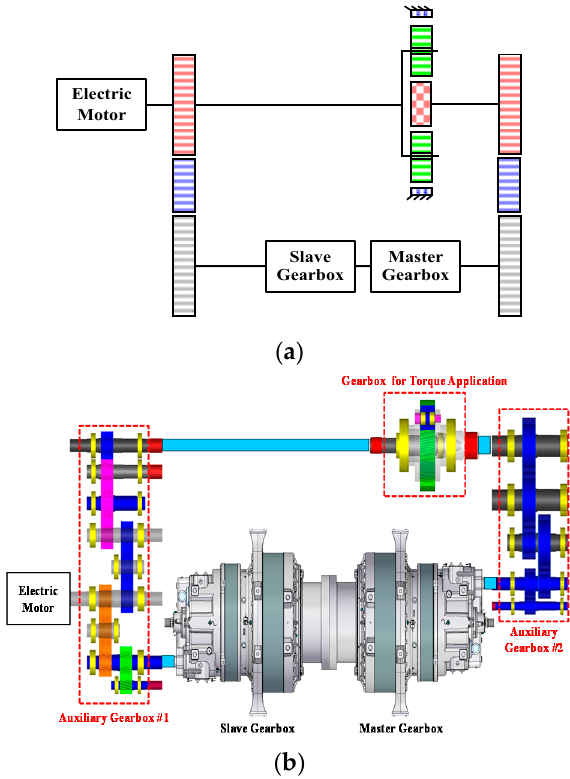
Figure 5. Layout of the developed test rig. ( a ) Concept of the developed test rig ( b ) Configuration of the test developed rig.